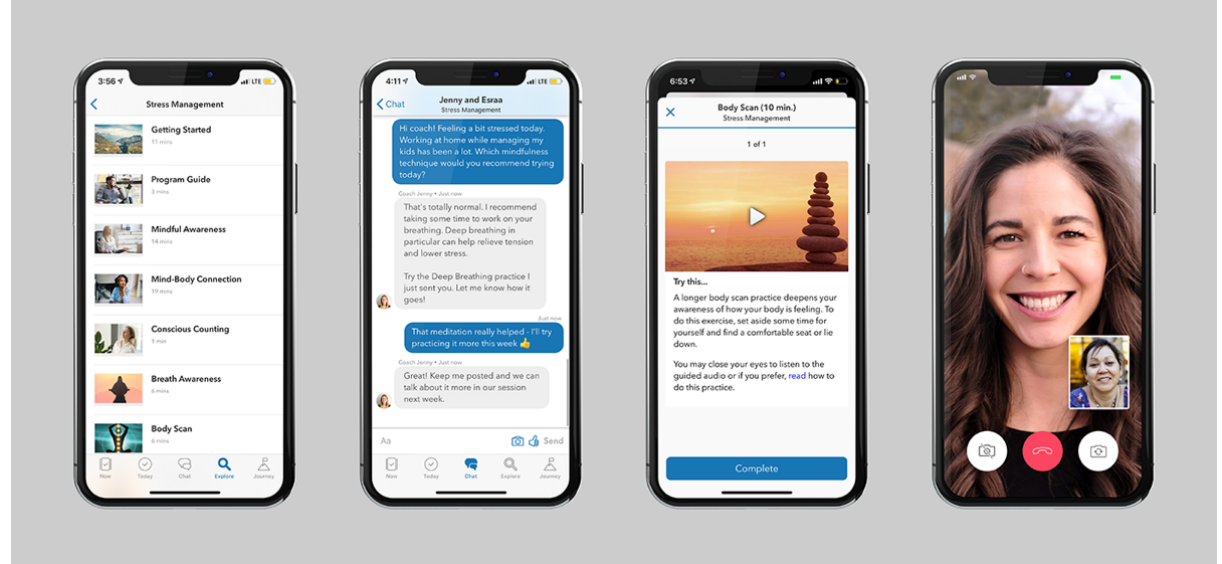
Figure 3. Features of the mobile app available to participants completing the mindfulness-based stress reduction